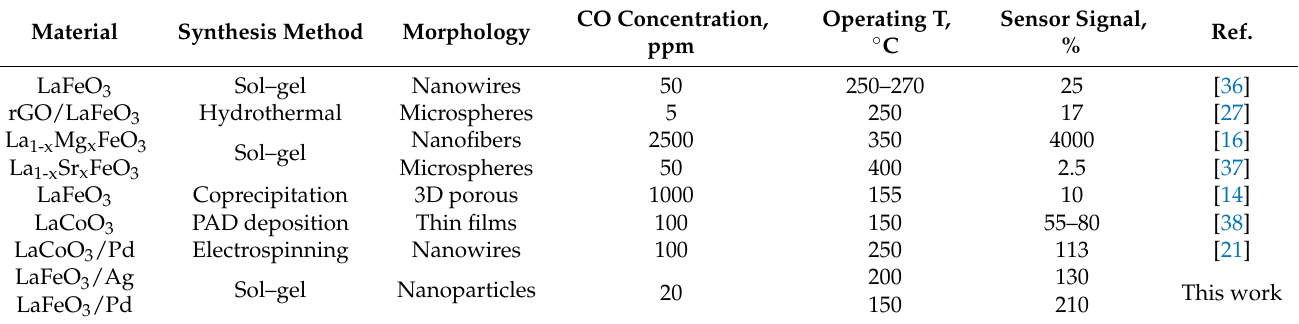
Table 4. Comparison of resistive sensor parameters for perovskite-type mixed-metal oxides in the detection of CO